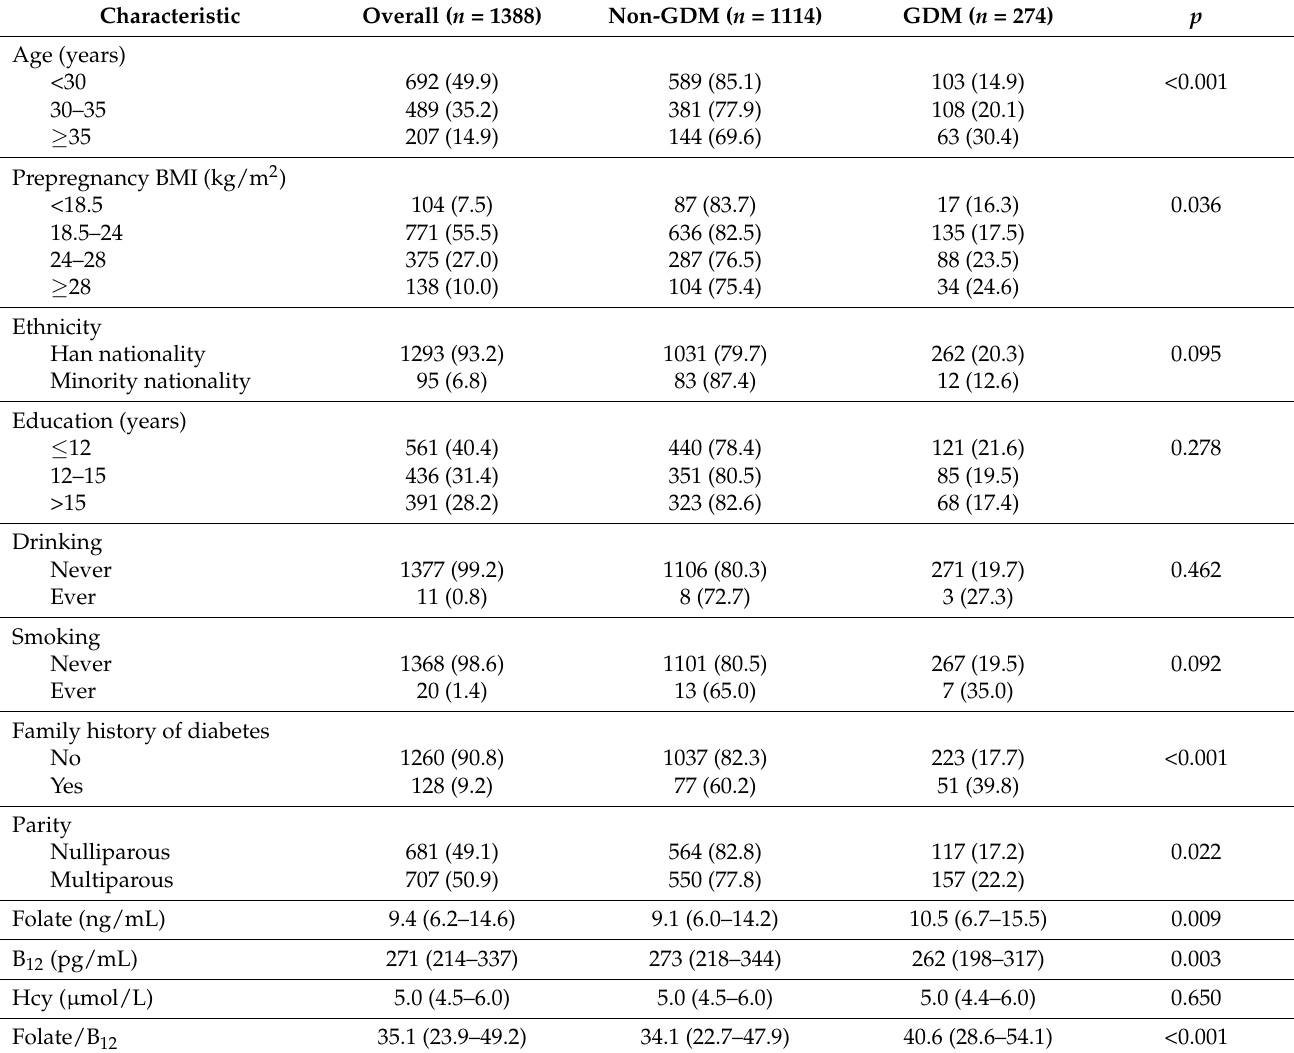
Table 1. Baseline characteristics of the study participants ( n =